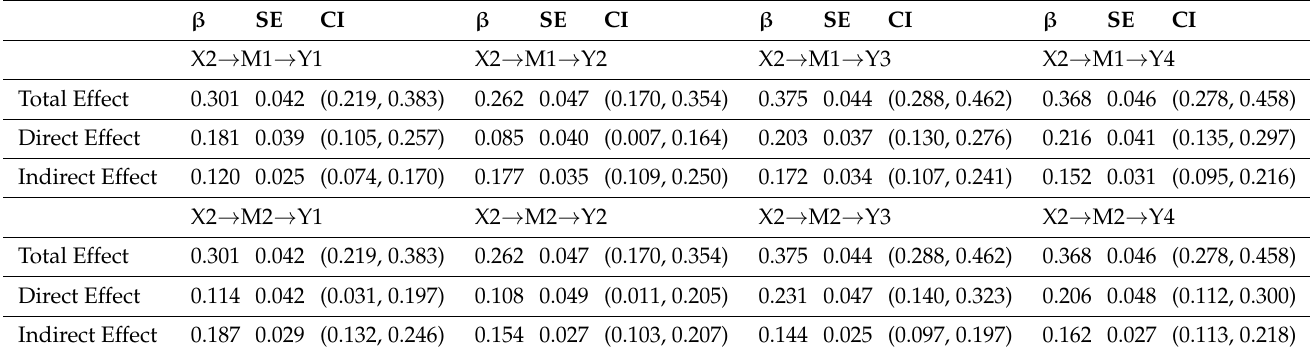
Table A2. Analysis of the mediating effect based on social image.